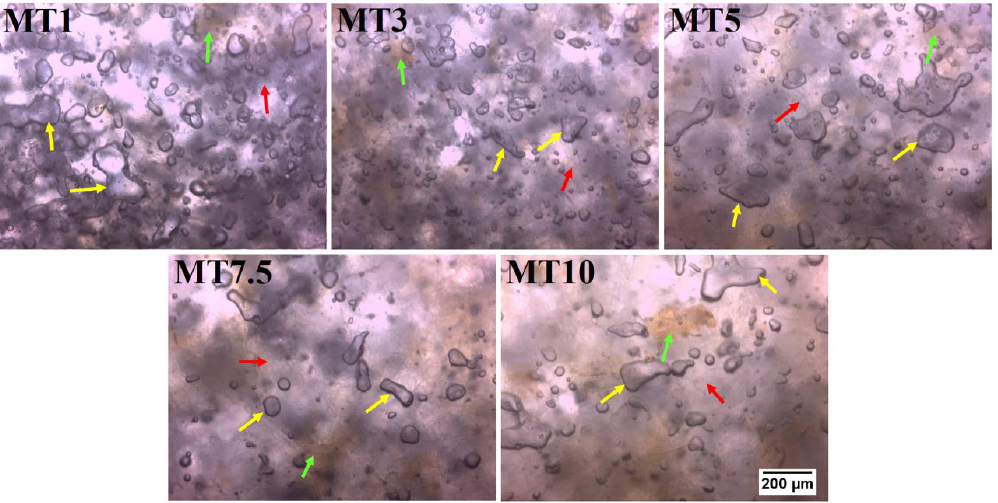
Figure 3. Bright-field micrograph of dough samples (Magnification 10×).